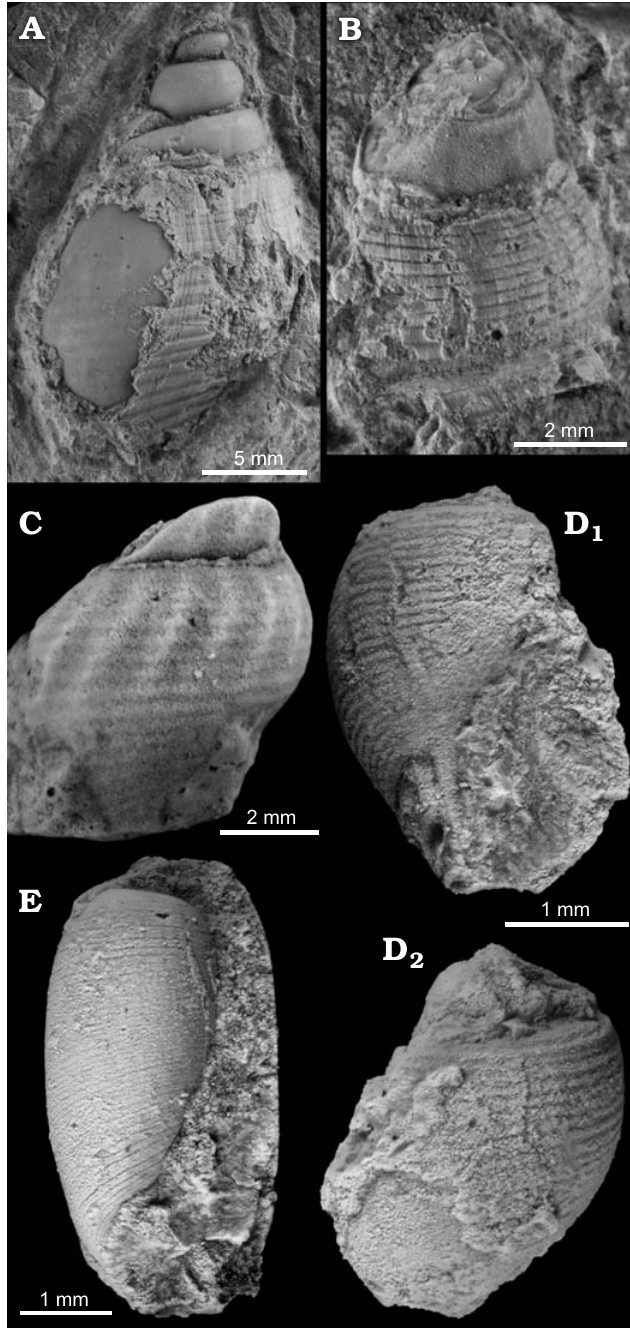
Fig. 17. Neogastropod and opisthobranch gastropods from early Oligocene seep deposits at Cerro La Salina (block 2, A; block 4, B; block 6, E; block 7, D) and Belén seep site (C), Talara Basin, northern Peru. A , B . The buc- cinid Colus sekiuensis Kiel and Goedert, 2007. A . Large specimen (NRM Mo187062), showing shape of last whorl. B . NRM Mo187063, fragment of an early whorl. C . Buccinidae indet. (NRM Mo187064), fragmentary specimen. D . NRM Mo187065, the opisthobranch “ Acteon ” sp. in aper- tural (D 1 ) and lateral (D 2 ) views. E . The opisthobranch Cylichna sp. (NRM